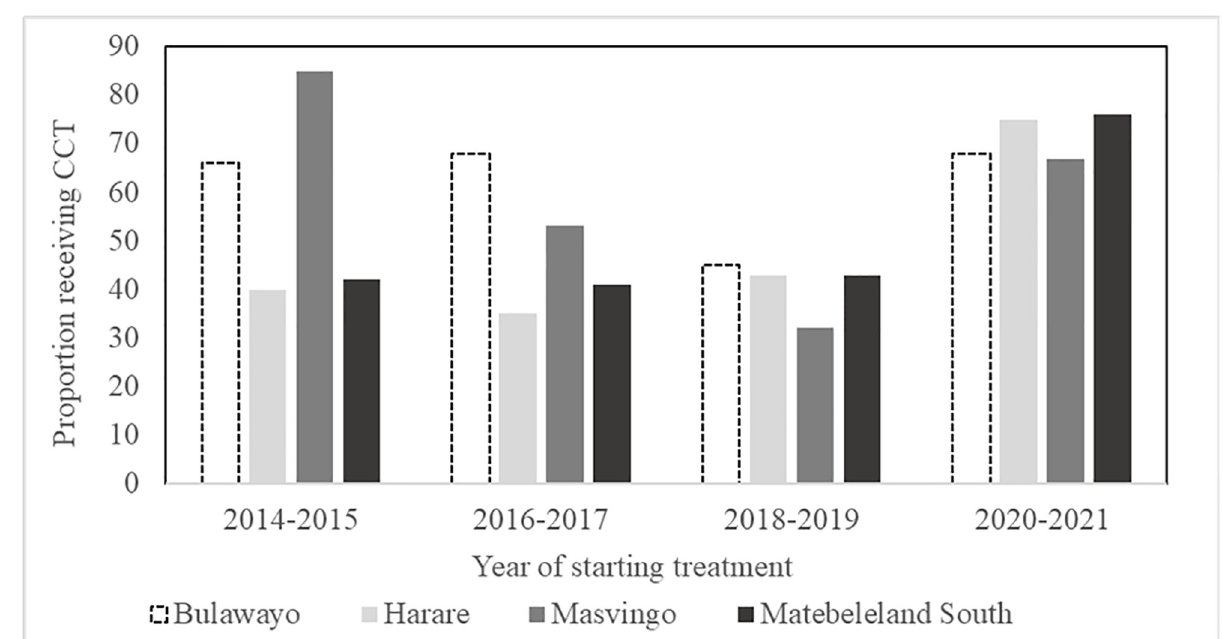
Fig 1. Proportion of people with DR-TB who received CCT by province and year of enrolment, 2014–2021, Zimbabwe.